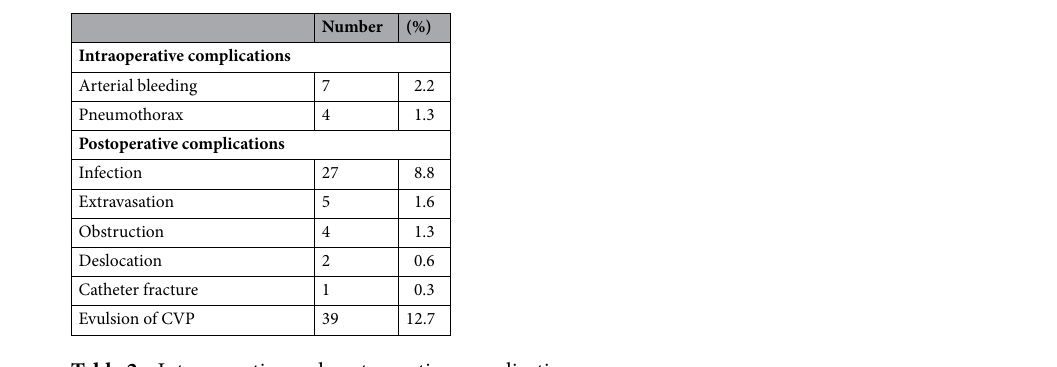
Table 2. Intraoperative and postoperative